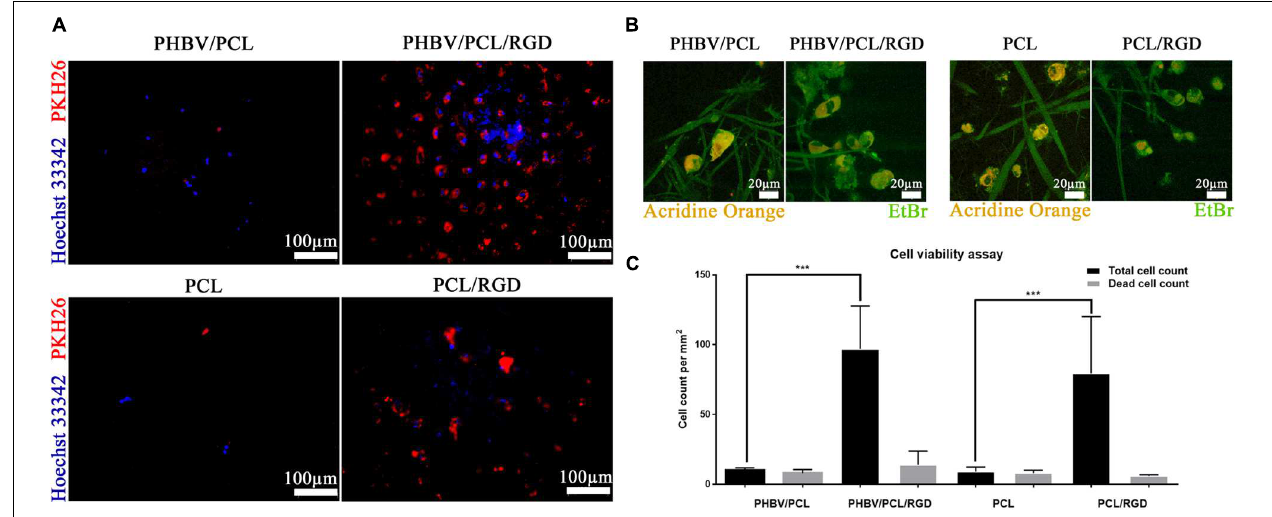
FIGURE 5 | PHBV/PCL and PCL scaffolds with RGD peptides improve cell viability. (A) Fluorescence microscopy showed several-fold increase in total cell count on PHBV/PCL and PCL scaffolds with RGD peptides in comparison with those without. Nuclei and cytoplasm are stained blue and red, respectively. (B) Confocal laser scanning microscopy confirmed the results obtained by fluorescence microscopy. Nuclei of the dead cells are stained orange whilst viable cells are stained green. (C) Quantitative analysis confirmed the results of microscopy analysis, data are represented as median with interquartile range, ∗∗∗ P < 0.001, Mann–Whitney U -test.